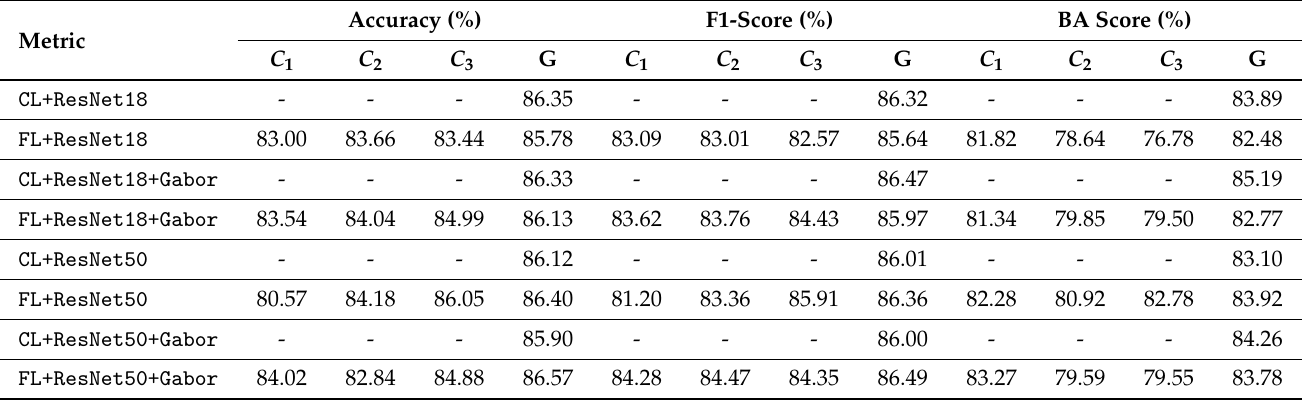
Table 3. Patch-wise comparison of our proposed models with studies from the literature on the BHI